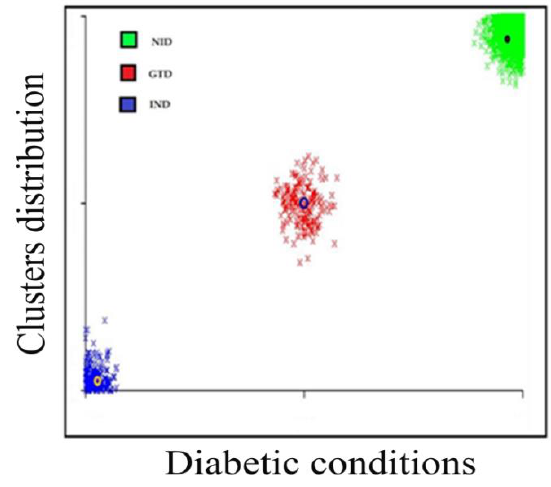
Figure 3. K-means cluster assessments for the patient’s diabetic conditions.